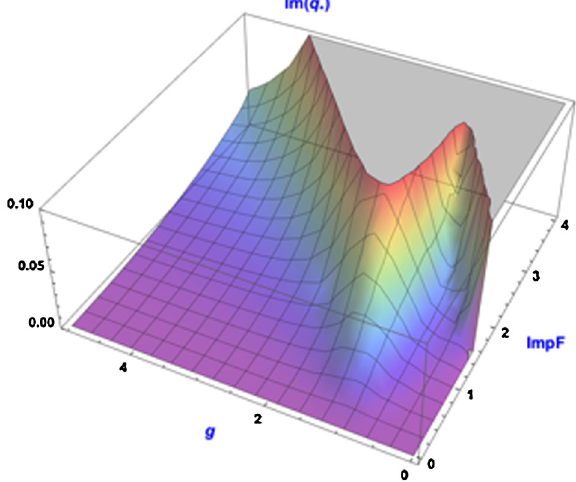
FIG. 21. Growth rate for zero chromaticity and almost reactive damper, which phase declines towards resistive by 18°.